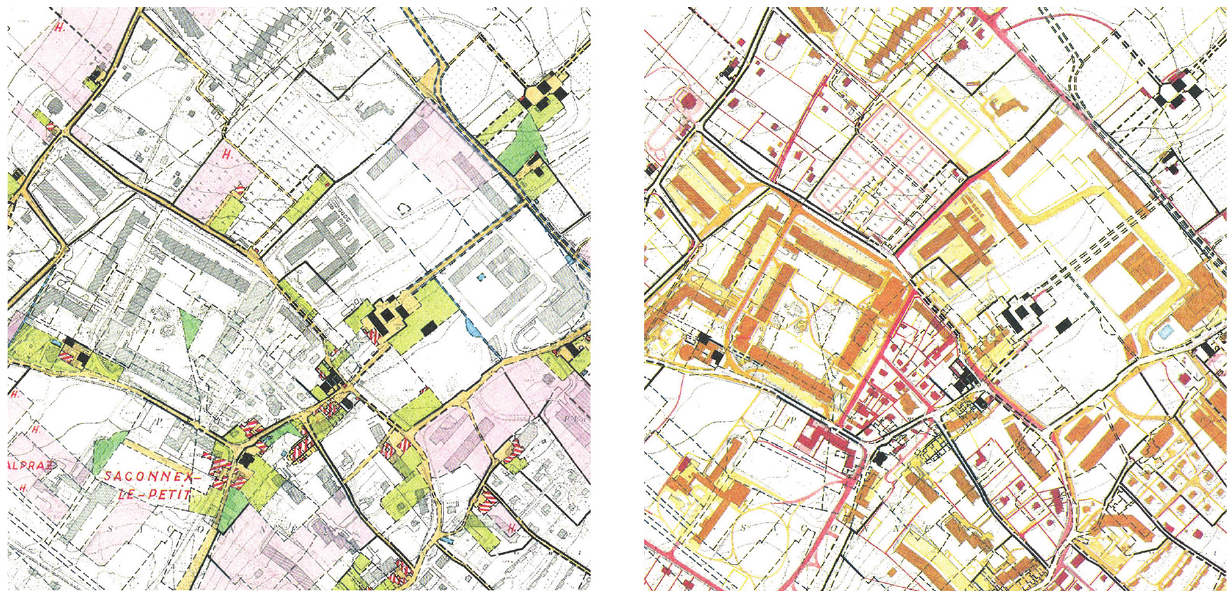
Figure 1. Atlas du Territoire Genevois. Left: Transcription of the Napoleonic cadastre to the 1991 plan. Synchronous reading of two states of the territory 170 years apart. Right: Comparison among the Napoleonic cadastre, the 1935–59 plan, and the 1991 plan. Formation/transformation of the territory 19th and 20th century; diachronic reading by attributing histori- cal coordinates to each element of the built morphology (roads, parcel, building). Source: Service des Monuments et sites de la République et Canton de Genève (Léveillé et al.,